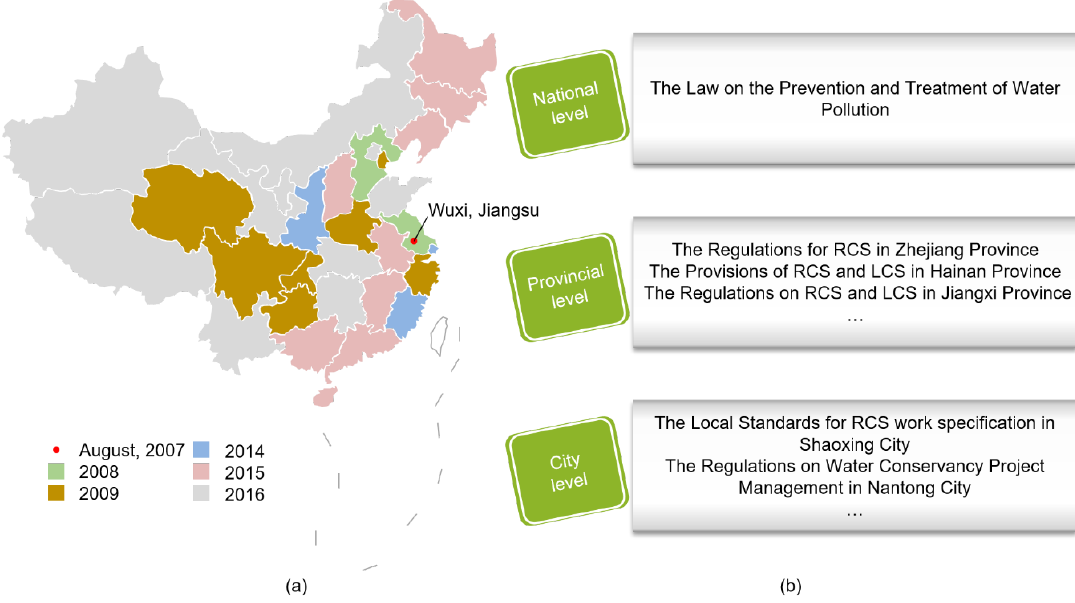
Figure 1. ( a ) Policy diffusion of the River Chief System (RCS) from 2007 to 2016; ( b ) Regulations and normative documents of the RCS at various administrative levels. (Source: official website and media of each provincial government).